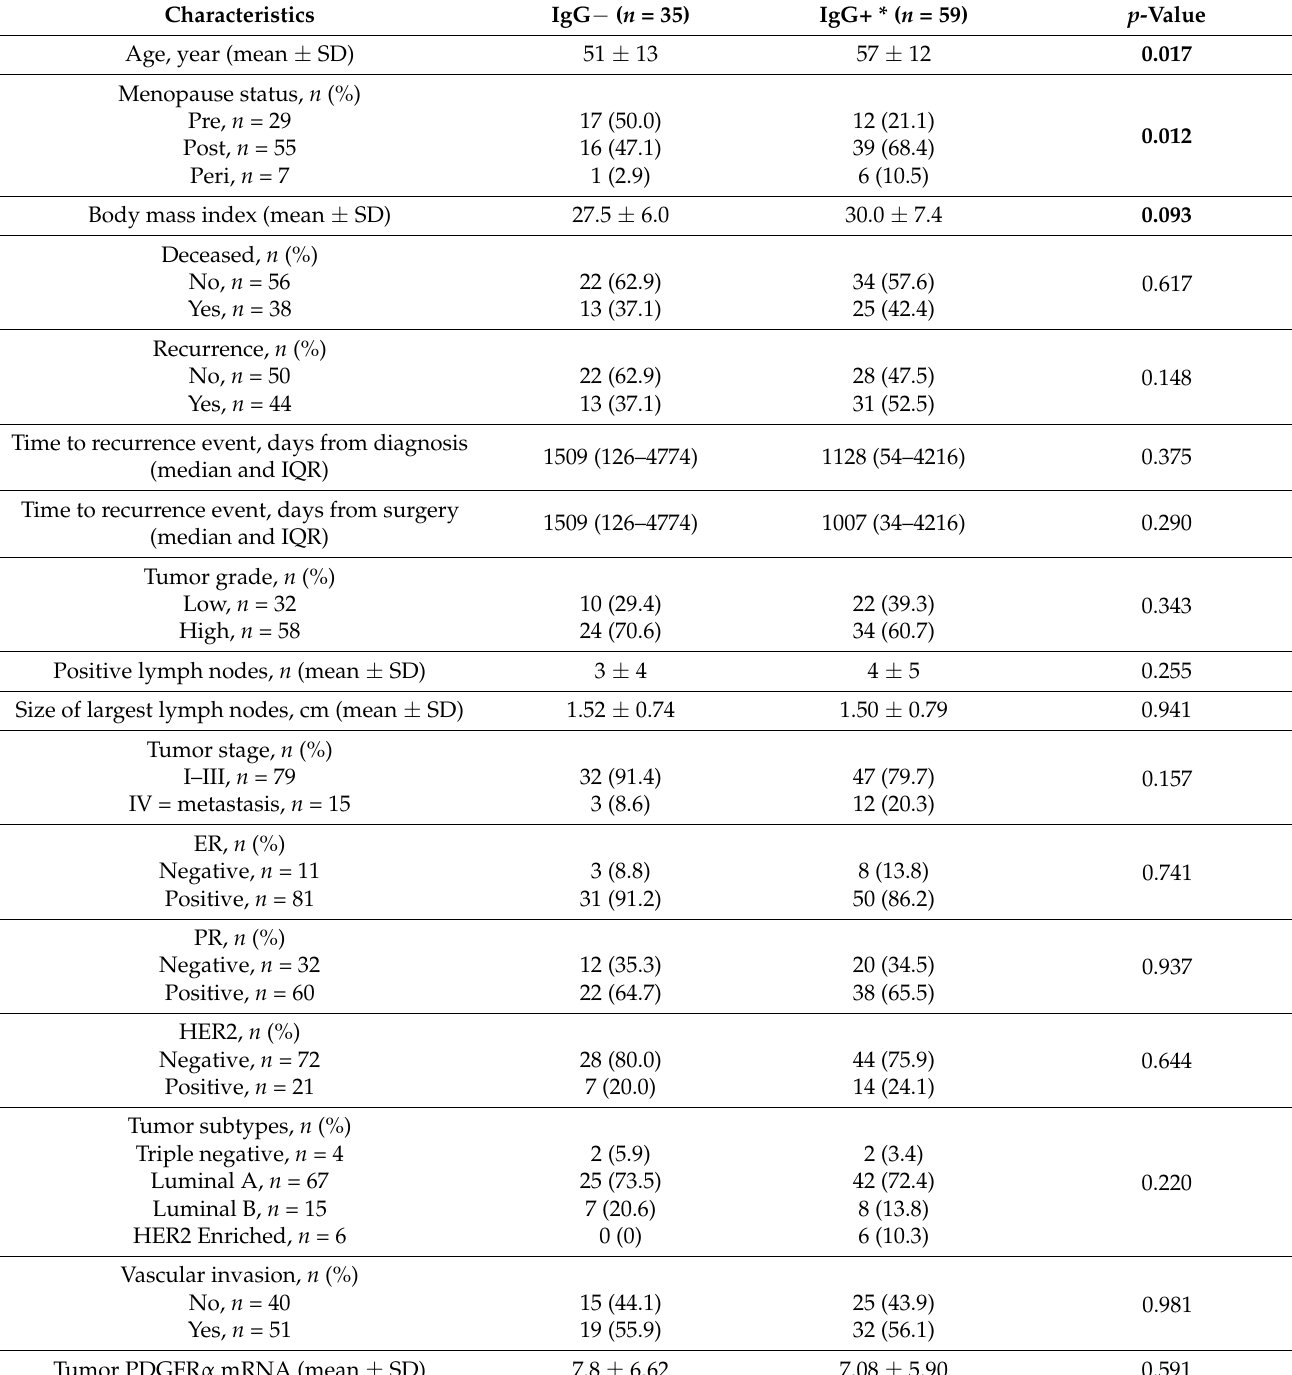
Table 4. HCMV IgG seronegative and seropositive patients: univariate analysis of patient characteristics.